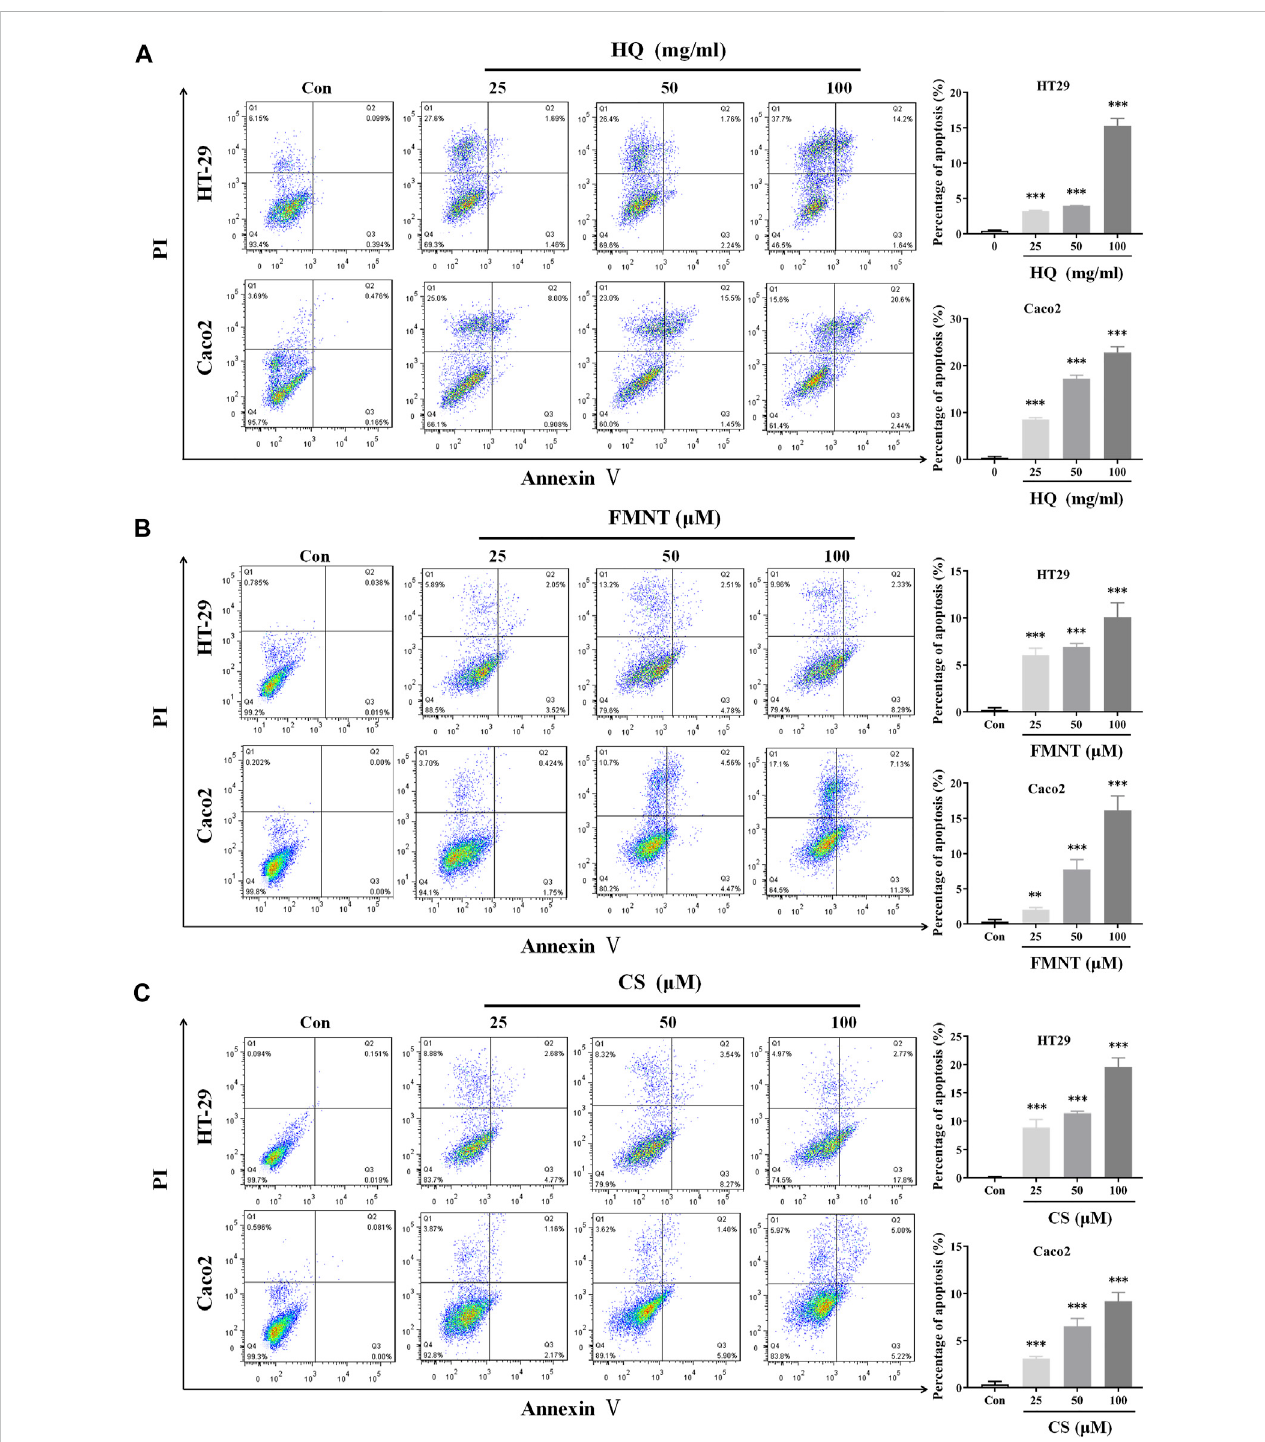
FIGURE 7 HQ, FMNT and CS signi fi cantly induced apoptosis of HT29 and Caco2 cells. The effects of HQ (25, 50 and 100 mg/mL, 48 h) (A) , FMNT (25, 50 and 100 μ M, 48 h) (B) and CS (25, 50 and 100 μ M, 48 h) (C) on the apoptosis of HT29 and Caco2 cells. The data represent the mean ± SD ( n = 3). ** p < 0.01 and *** p < 0.001 compared with the control